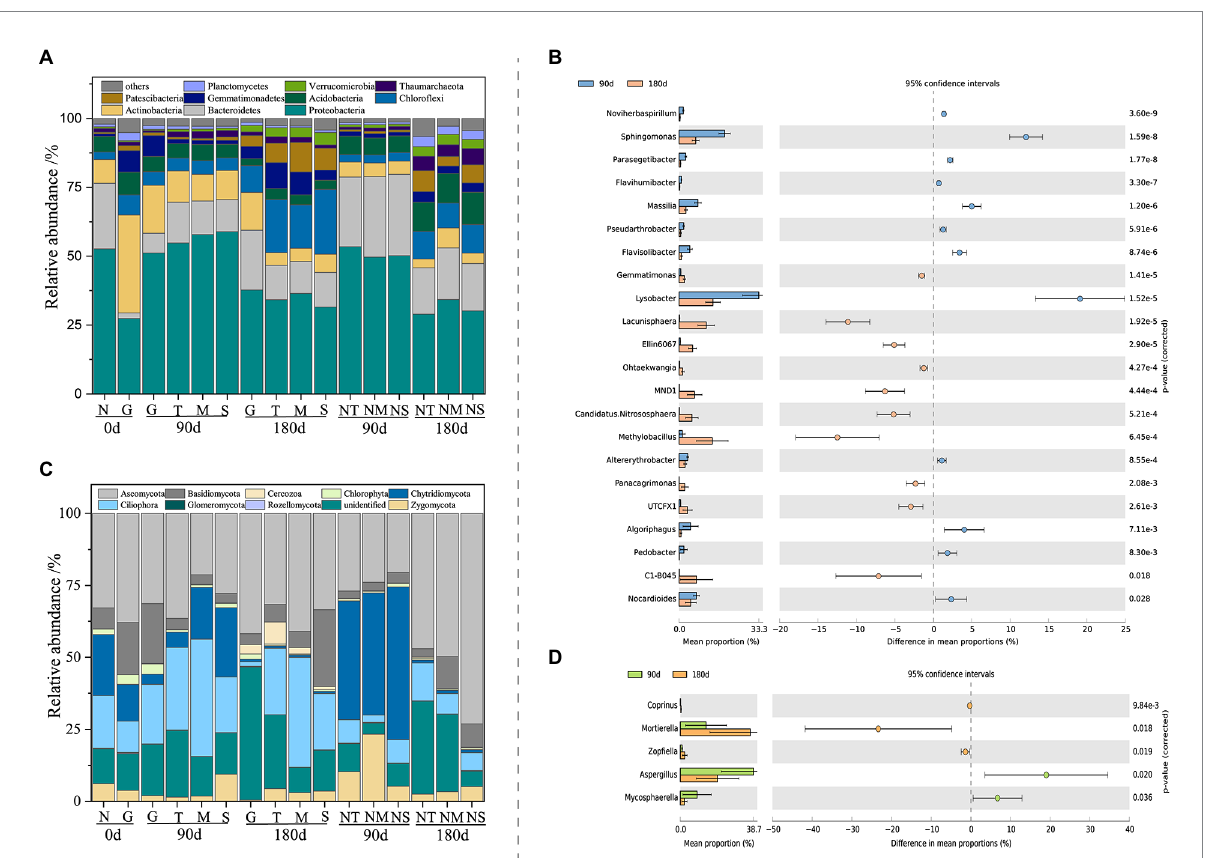
FIGURE 2 Relative abundance of bacterial (A) and fungal (C) phyla in different soil samples. The differentially abundant of bacterial (B) and fungal (D) genera between 90-day and 180-day treatment ( n = 3). N, control group; T, top layer; NT, top layer of control group; M, middle layer; NM, middle layer of control group; S, substratum layer; NS, substratum layer of control group; G, Cr slag layer. between bacterial and fungal communities, and there were more (Figures 2A,B) and fungi (Figures 2C,D) were compared. The unique OTUs during the LP compared to ND. This suggested that bacterial phyla Proteobacteria, Actinobacteria, Bacteroidetes, the diversity of microbial species composition was higher in the LP Acidobacteria, Gemmatimonadetes, and Chloroflexi and the than in the ND treatment. To clarify the microbial compositions at fungal phyla Ascomycota, Zygomycota, Ciliophora, and the LP and ND stages, the dominant phyla and genera of bacteria Chytridiomycota were dominant in the soil of the CK group.